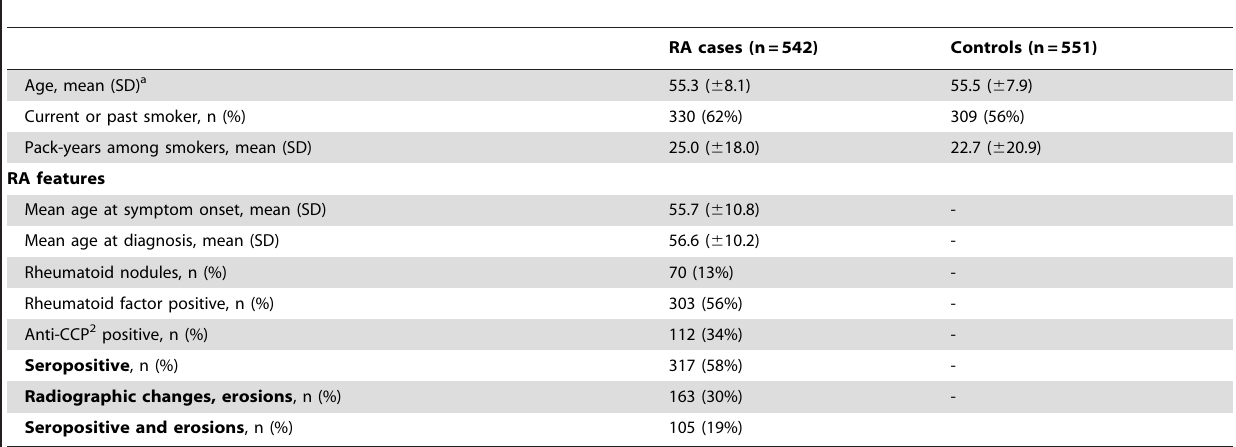
Table 1. Characteristics of RA cases and controls in the Nurses’ Health